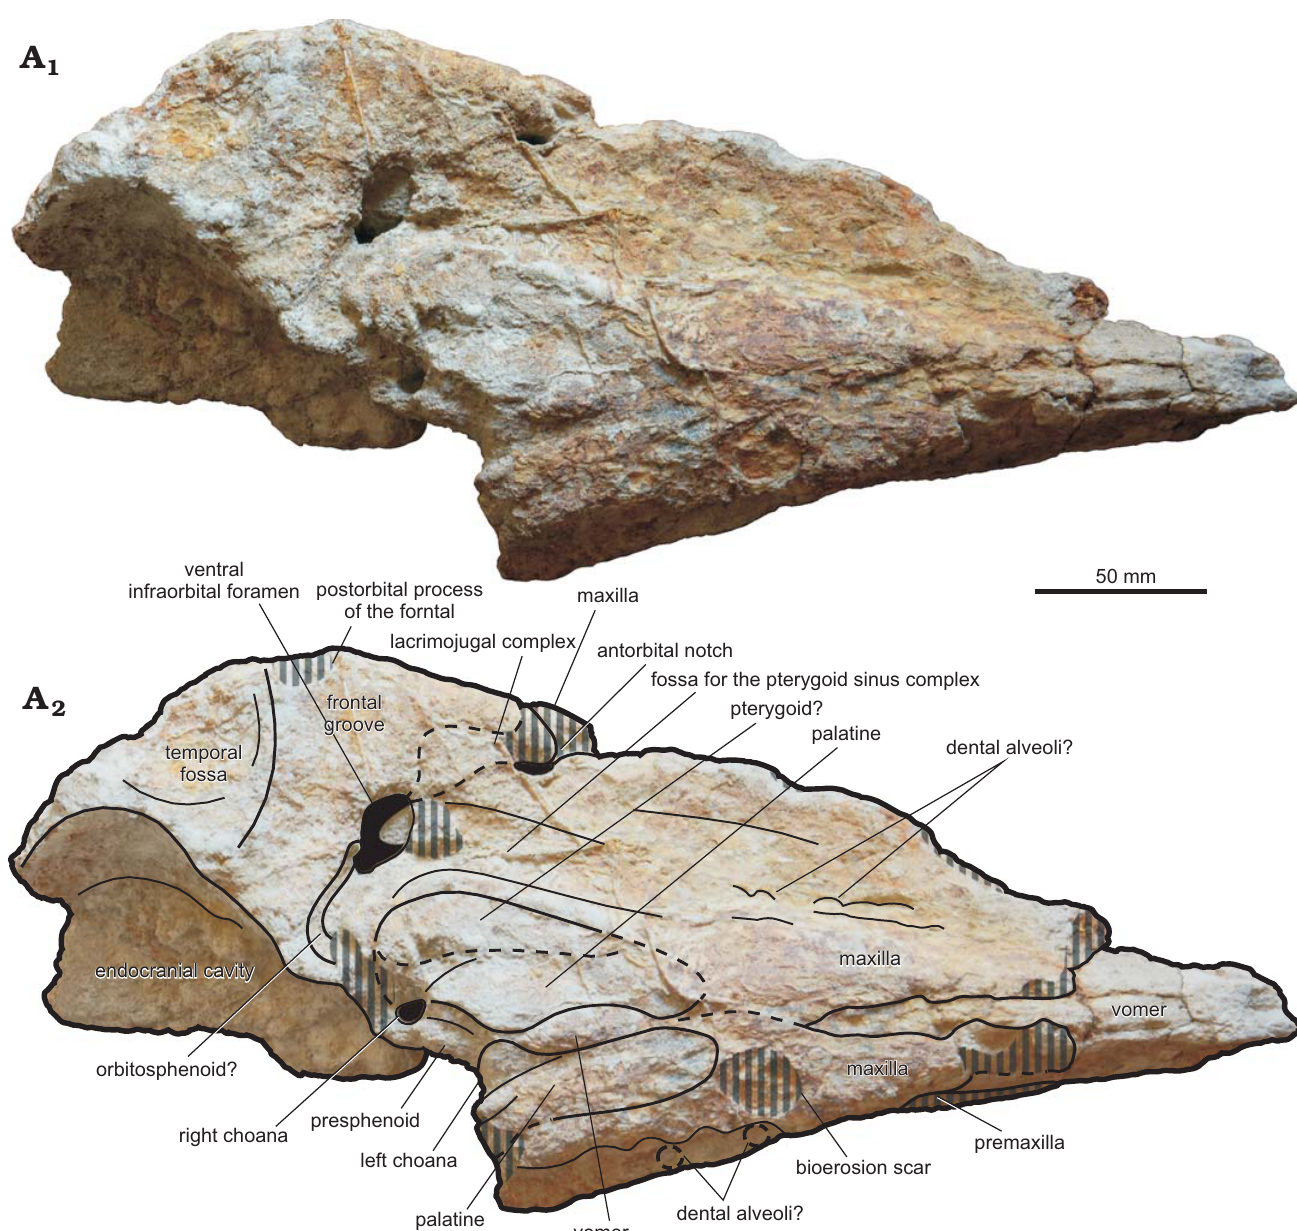
Fig. 3. Cranium, in ventral view, of the kogiid sperm whale Pliokogia apenninica gen. et sp. nov. (MSNUP I-17603, holotype), from the lower Pliocene of Sant’Andrea Bagni (Northern Apennines, northern Italy). Photograph (A 1 ), explanatory drawing (A 2 ). The black-shaded areas correspond to openings in the skull. The grey vertical stripes denote abraded or broken areas. Dashed lines for approximating the position of several sutures and